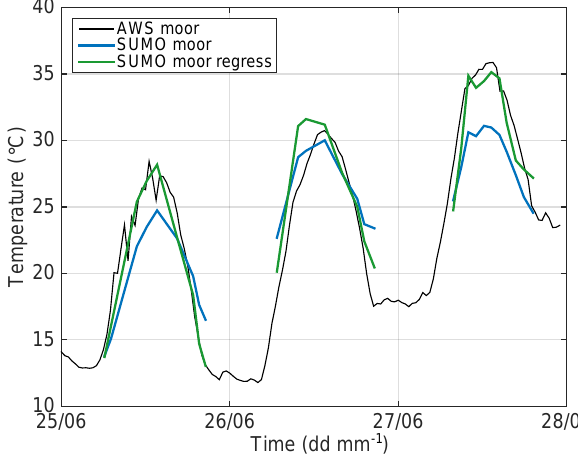
Figure 13. Time series of surface temperature from the moor area using a net radiometer, unaltered SUMO data and corrected SUMO data using the multiple linear regression